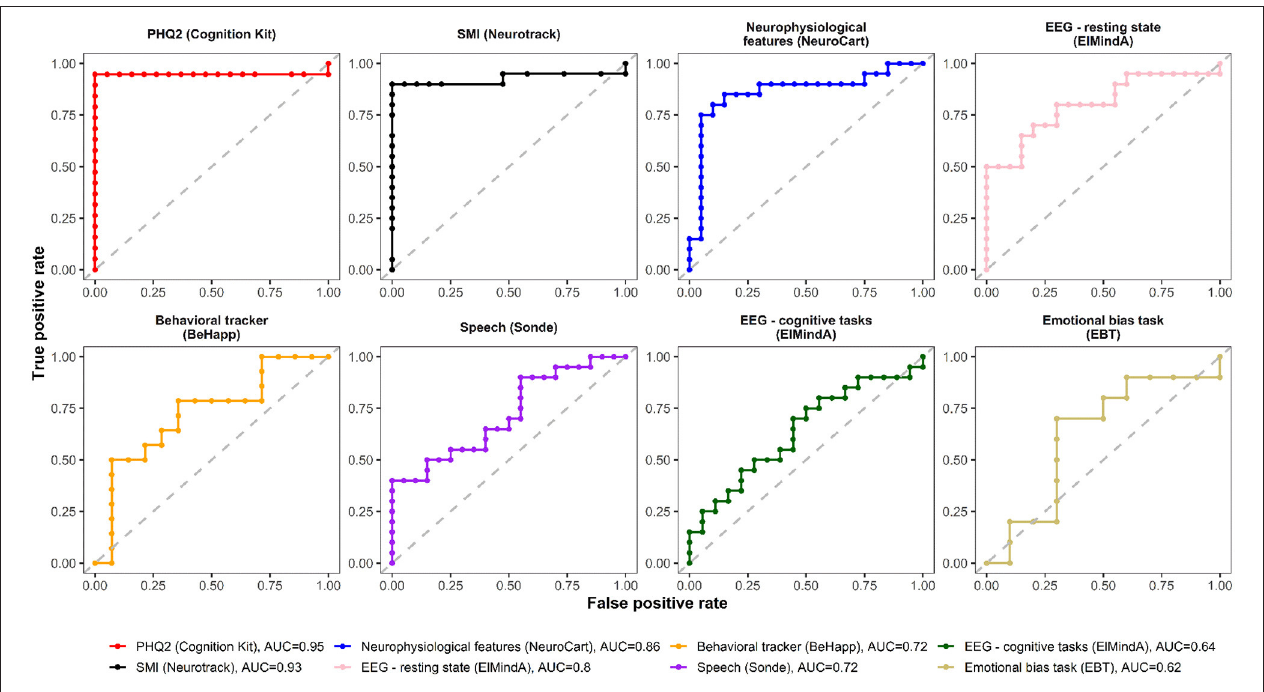
FIGURE 4 | ROC curves of classifiers based on logistic regression using different digital technology features.